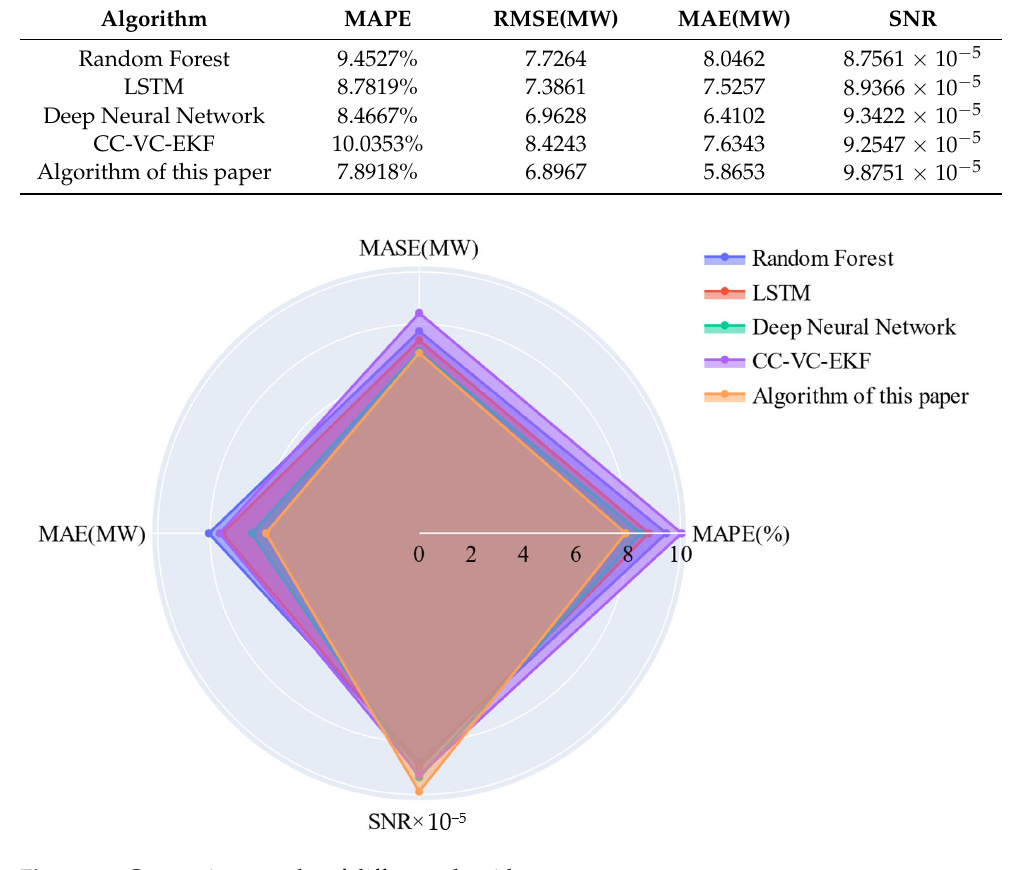
Figure 16. Comparison results of different algorithms.